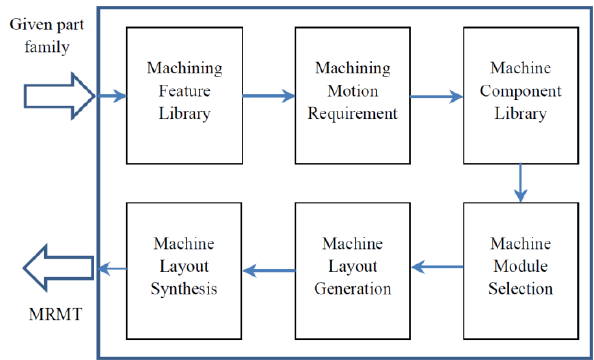
Figure 1. Design system for modular reconfigurable machine tools.